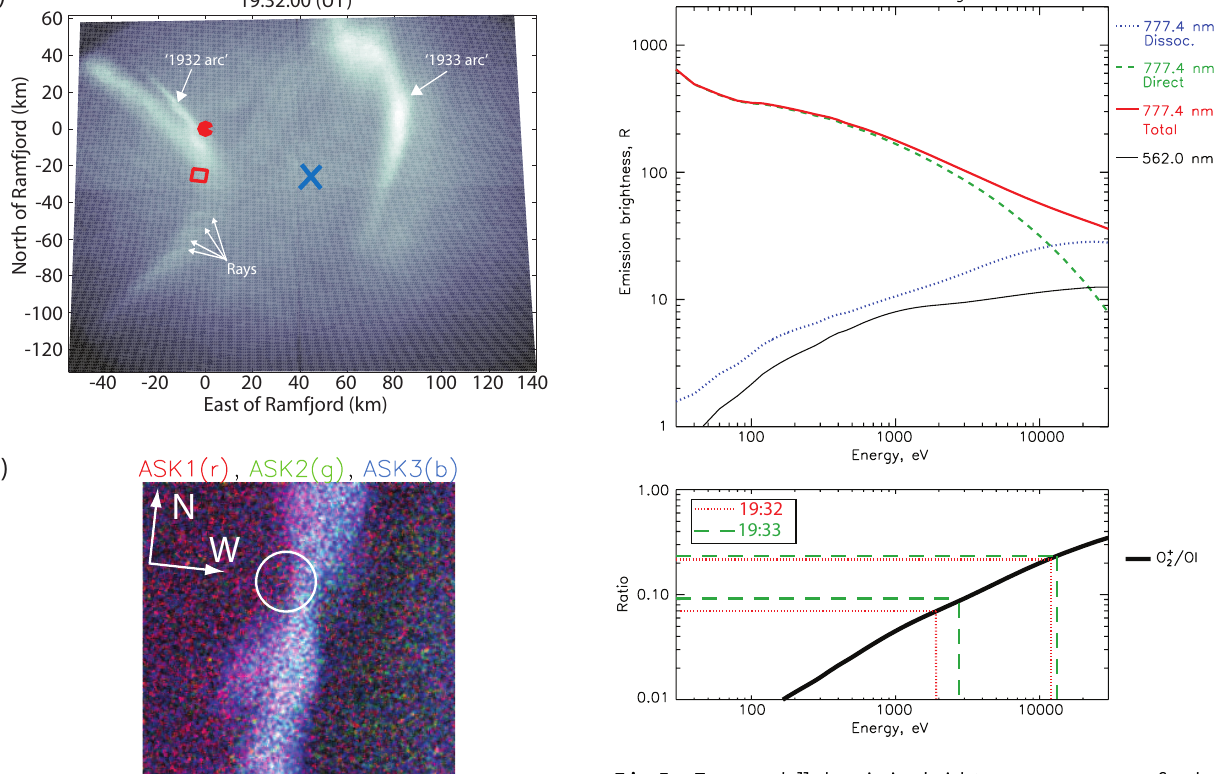
Fig. 5. Top: Modelled emission brightness versus energy for the ASK emissions. Bottom: Modelled emission ratio versus energy (black). The minimum and maximum ratios are plotted as red dotted lines for the 1932 arc, and as green dashed lines for the 1933 arc. O + 2 (red),